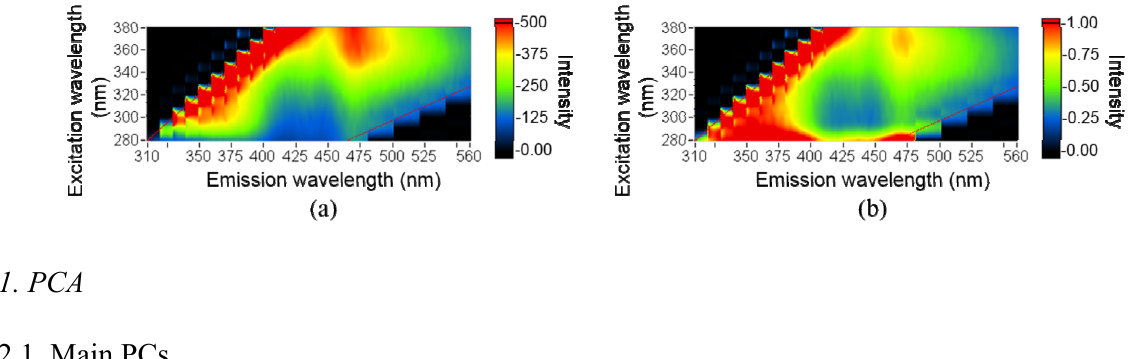
Figure 1. ( a ) Original excitation-emission matrix (EEM); ( b ) Normalized EEM. The collected data are between two oblique lines.